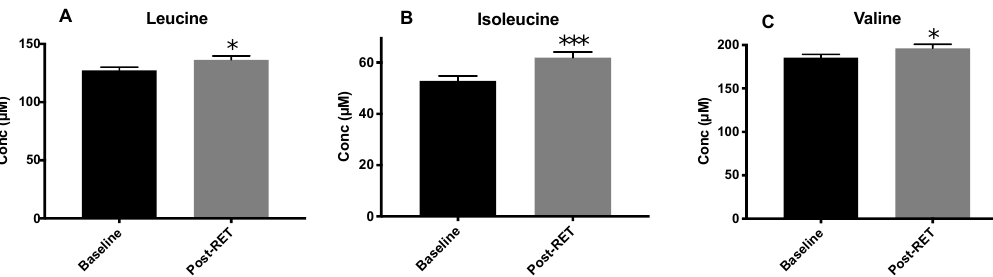
Figure 2. Circulating plasma leucine ( A ), isoleucine ( B ) and valine ( C ) at baseline and after 20 weeks, fully supervised, whole-body resistance exercise training (RET) ( n = 32). Bars represent mean and SEM. Quantification achieved via GC-MS with reference to a calibration curve. Statistical analysis via paired t-tests. * p < 0.05; *** p < 0.001 vs. baseline.